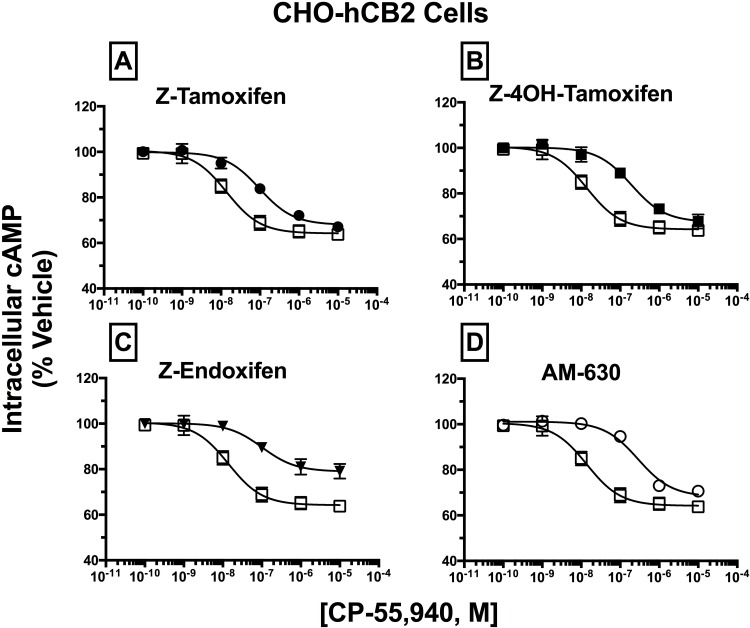
Antagonism of CP-55,940 inhibition of forskolin-stimulated AC activity by SERM isomers in intact CHO-hCB2 cells.CHO-hCB2 cells were pre-incubated for 30 min with receptor saturating concentrations of individual SERMs and were co-incubated for 7 min with increasing concentrations of the agonist CP-55,940. Measurements of CP-55,940 effects alone on potency (IC50) and efficacy (EMAX) of intracellular cAMP were obtained and were compared to the shifts in IC50 and EMAX values observed in [A-D]. All IC50, EC50, and KB values (mean ± SEM) were derived from non-linear regression analysis of the curves shown in [A-D] and are presented in Table 4 with statistical analysis. Open squares represent the concentration-effect curve for CP-55,940 alone, while filled symbols represent the action of CP-55,940 in the presence of the SERM indicated [A-C] or the selective CB2R inverse agonist AM-630 [D].